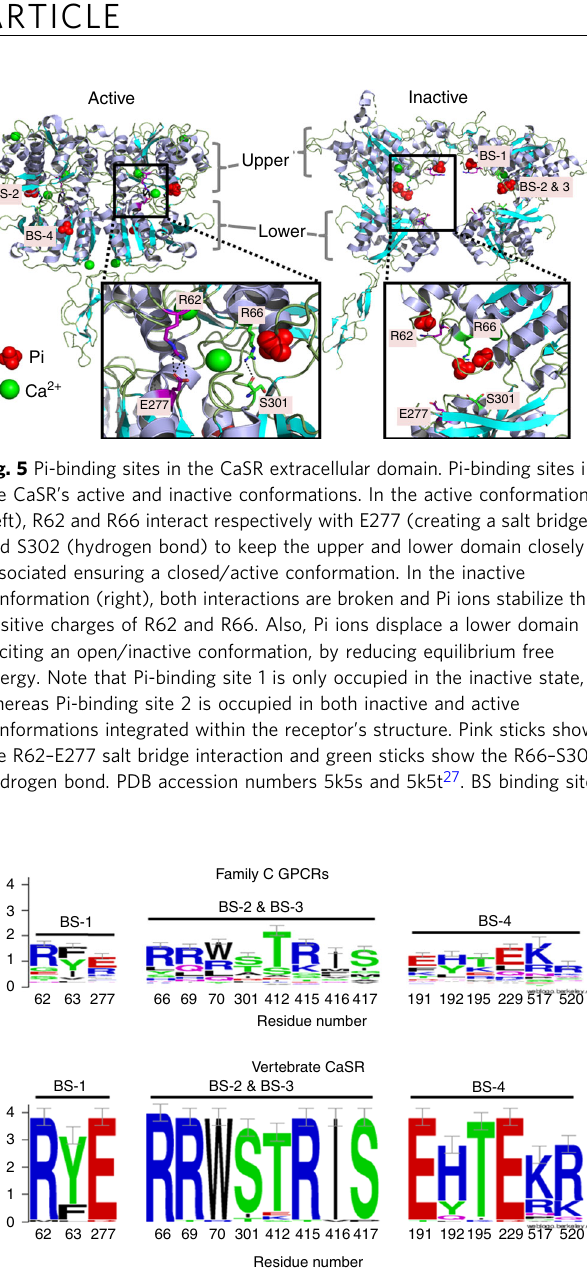
Fig. 6 CaSR Pi-binding sites are conserved across species. Phylogenetic analysis of the four Pi-binding sites within the CaSR ECD, represented with WebLogo and following the human numbering scheme 27 . The data set comprised 138 aligned nucleotide sequences from the family C GPCRs, including 42 CaSR sequences from different phylogenetic groups 29 . a Aligned amino acid positions from family C GPCRs, including CaSR. b Vertebrate CaSR subset reveals overall higher bit scores, re fl ecting stabilization and conservation of Pi-binding sites. Conservation at each amino acid position in the binding site is assessed as the WebLogo bit score, with amino acid usage frequencies at that position re fl ected in the relative size of the single-letter amino acid identi fi ers within the bit